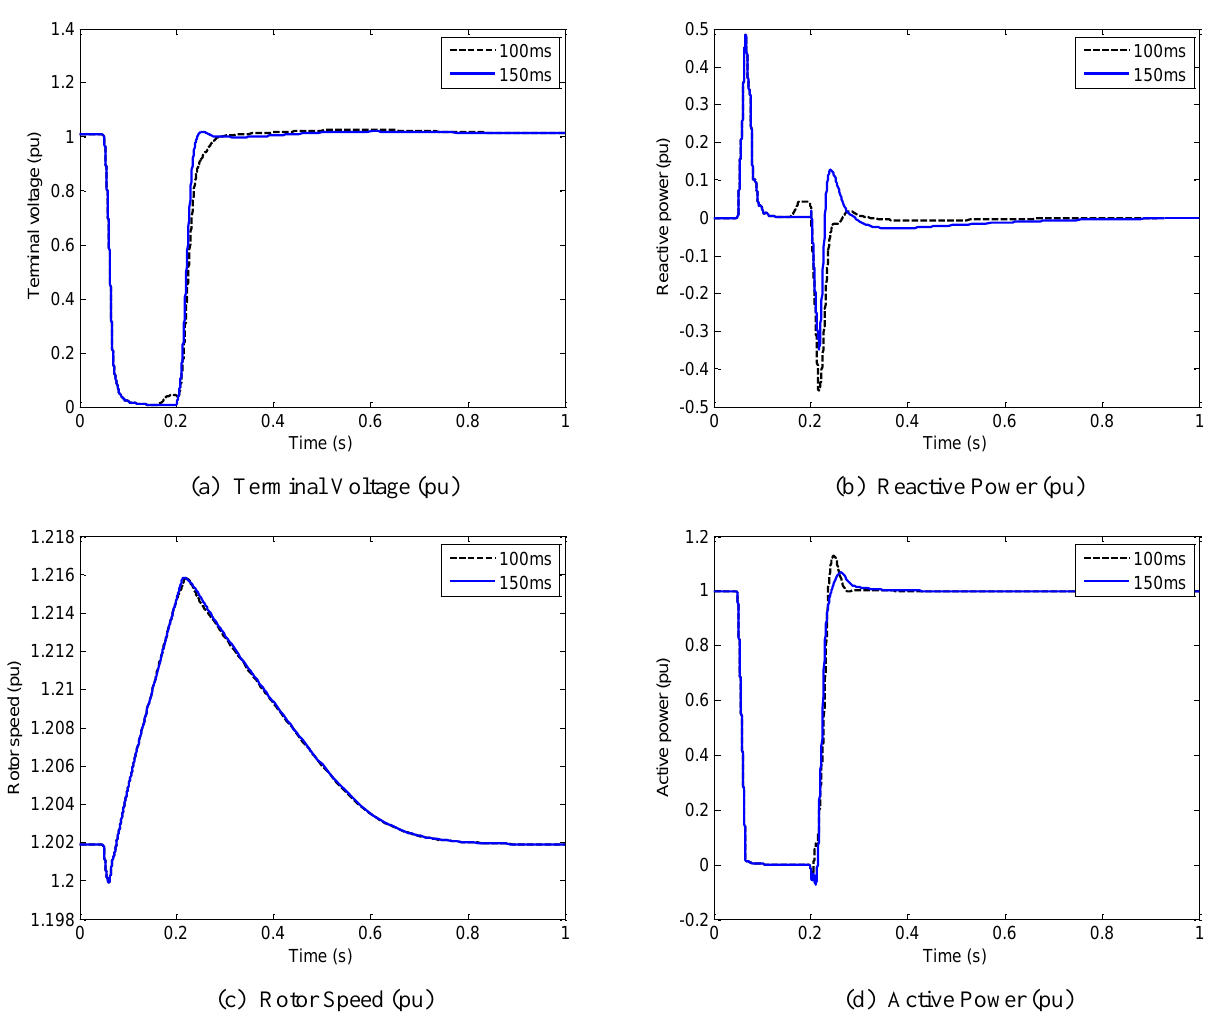
Figure 12. Dynamic analysis of the DFIG for different crowbar operation time during a fault at B7 eliminated in 150